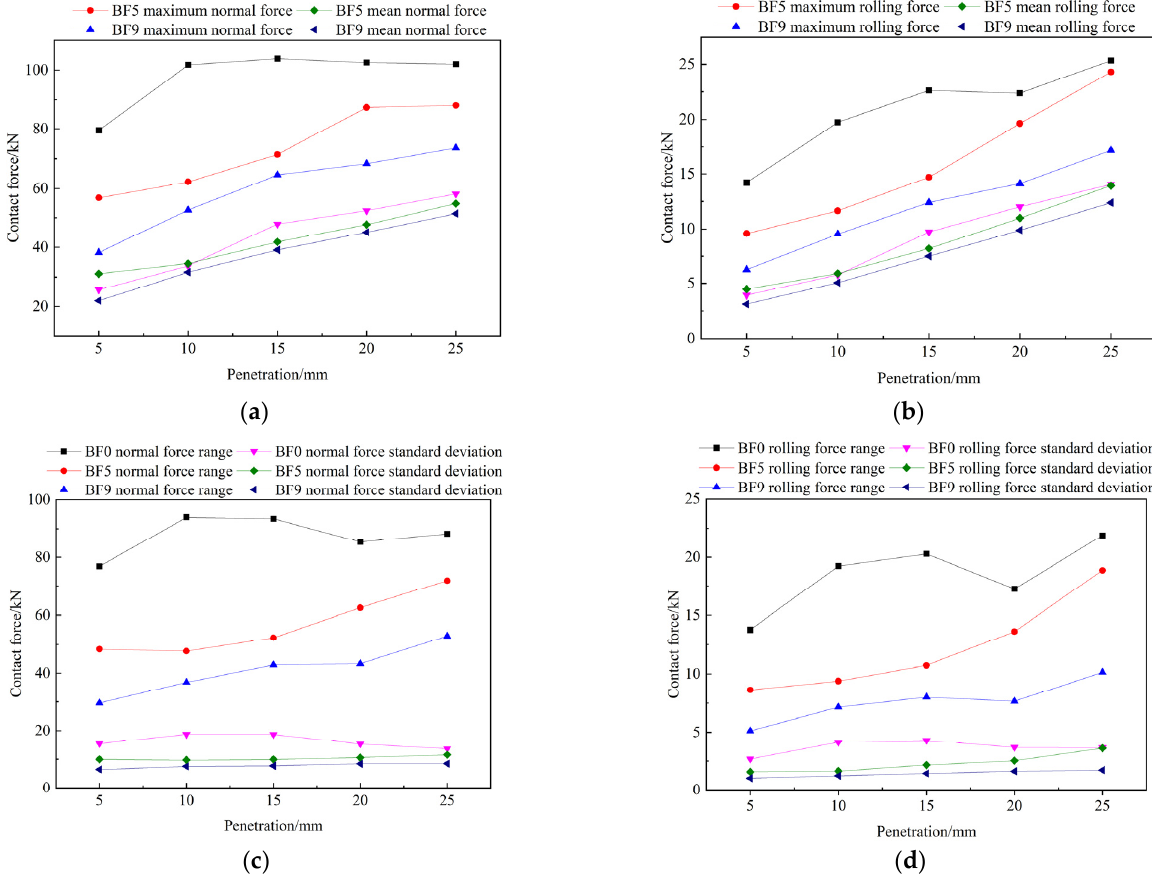
Figure 16. The contact force of BW 22mm disc cutter with different blade fillets. ( a ) Normal force; ( b ) Rolling force; ( c ) Range and STD of normal force; ( d ) Range and STD of rolling force.